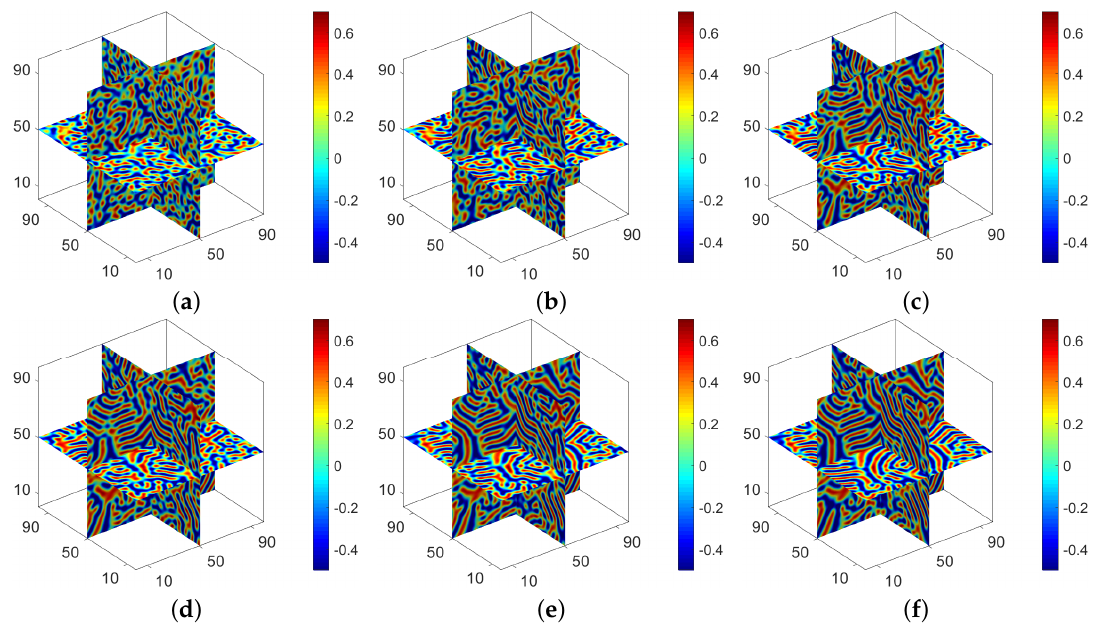
Figure 33. Temporal evolutions of the SH equation with the initial condition (86) using the Fourier-spectral method. ( a – f ) are snapshots at t = 400 ∆ t , 2000 ∆ t , 8000 ∆ t , 14,000 ∆ t , 20,000 ∆ t , and 24,000, respectively.